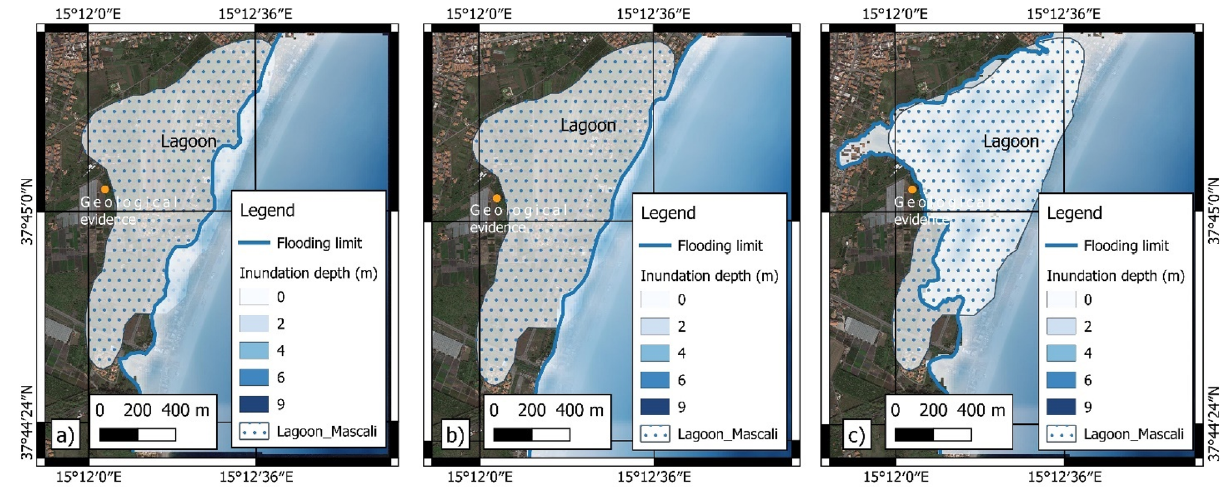
Figure 12. Modelling of tsunami inundation in the Mascali area; ( a ) SFS scenario; ( b ) SLS scenario; ( c ) DTS scenario. The maps were obtained by co-authors through QGIS—software (version 3.14.16); https:// www. qgis.